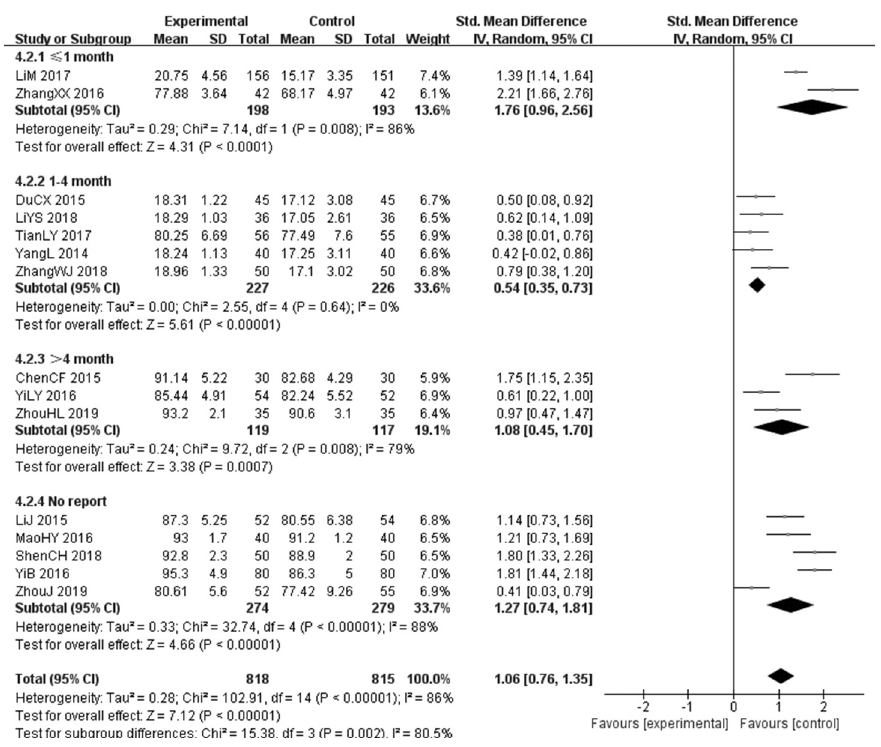
Figure 5. Subgroup analysis of the effect of intervention time on nursing students’ operational